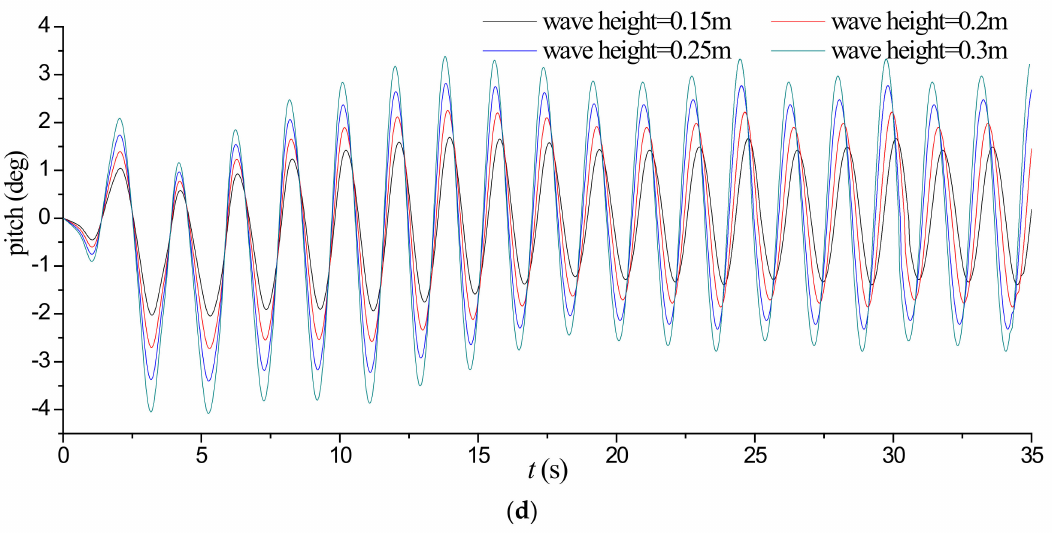
Figure 11. Curves of heave and pitch motions of wave-driven catamaran. ( a ) Curves of heave motion of hull under different wavelengths when the wave height is 0.25 m. ( b ) Curves of heave motion of hull under different wave heights when the wavelength is 8 m. ( c ) Curves of pitch motion of hull under different wavelengths when the wave height is 0.25 m. ( d ) Curves of pitch motion of hull under different wave heights when the wavelength is 8 m.